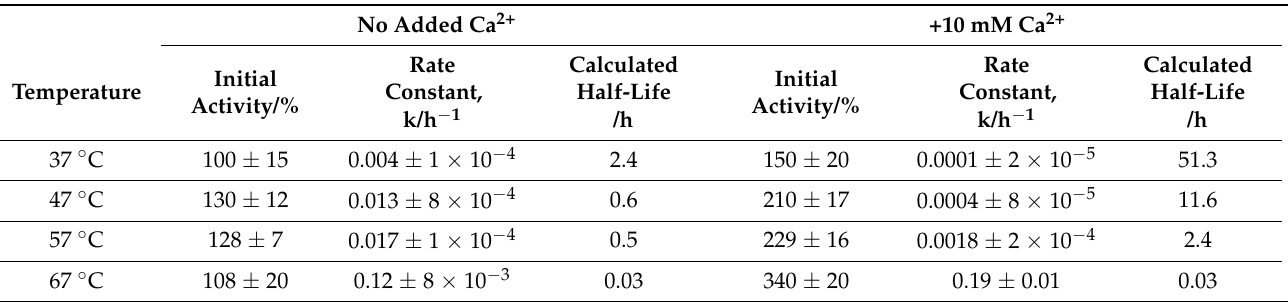
Table 1. Summary of trypsin de-activation rates at various temperatures in the presence or absence of calcium.